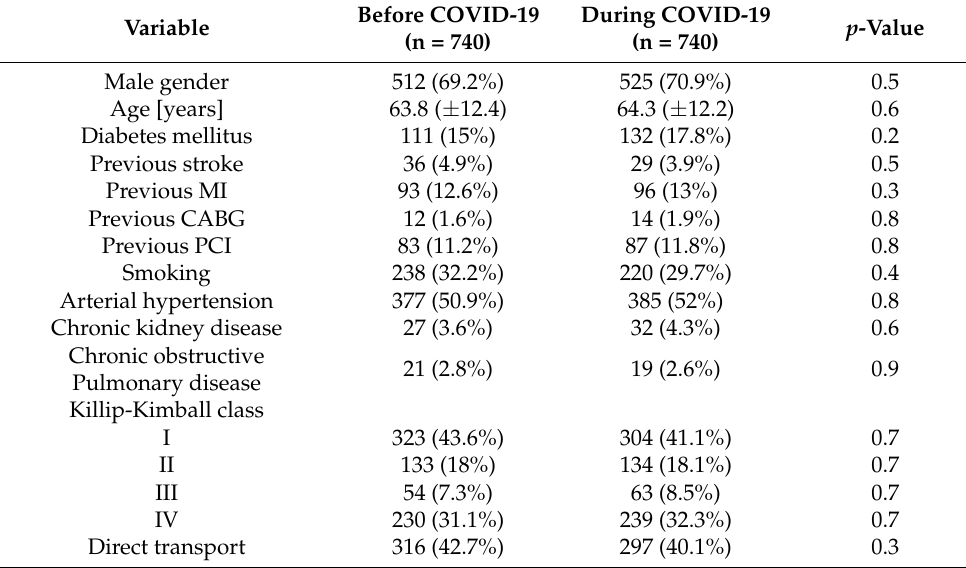
Table 1. Baseline characteristics after propensity score